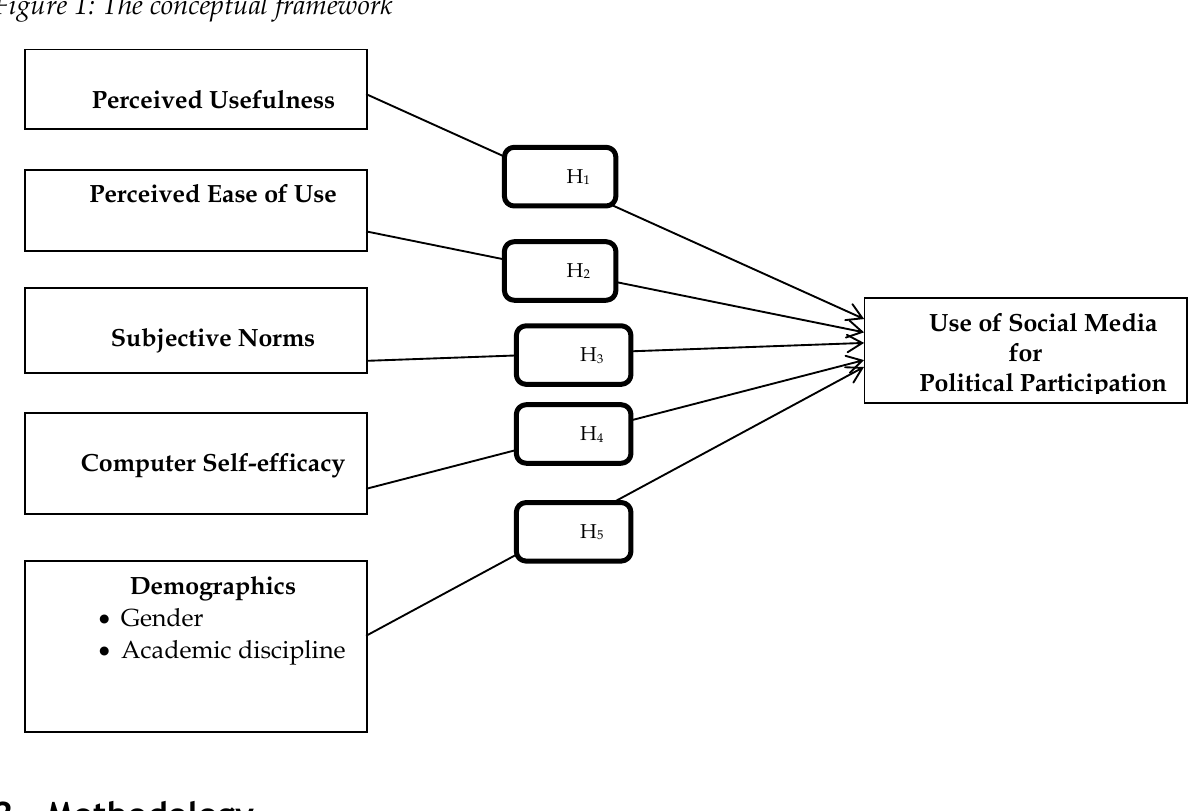
Figure 1: The conceptual